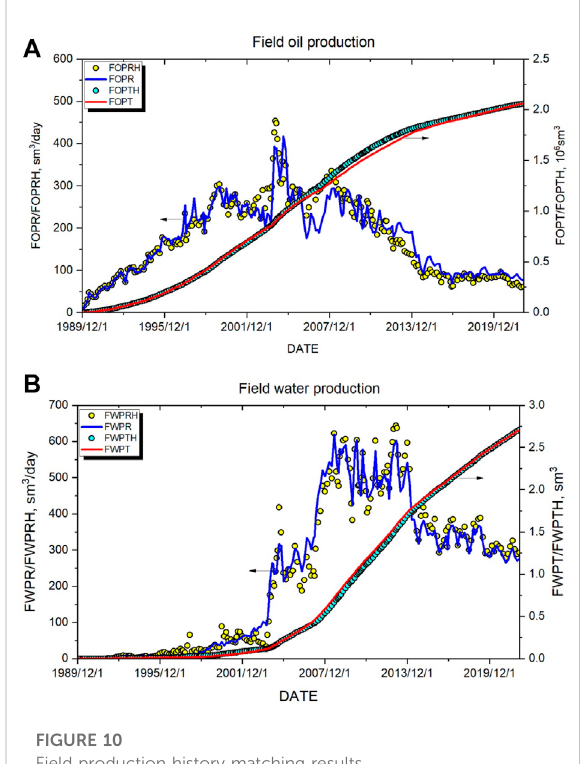
FIGURE 10 Field production history matching results.